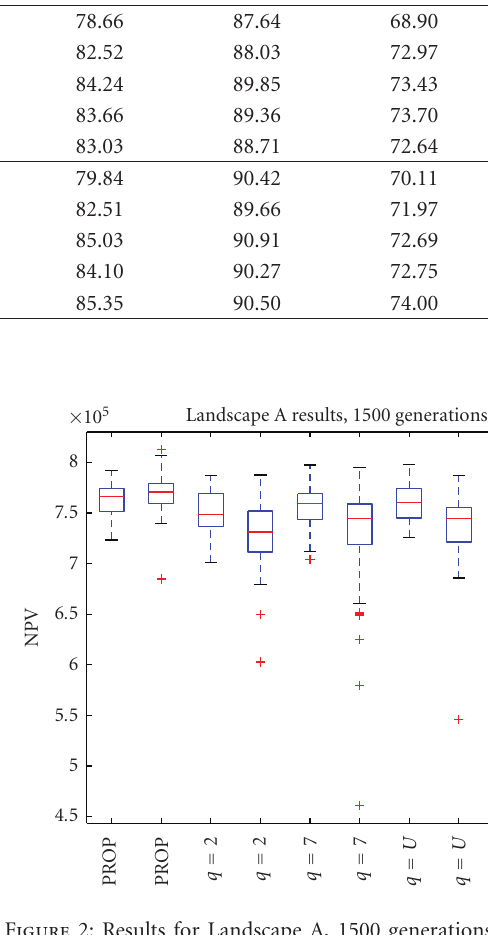
Figure 1: Results for Landscape A, 750 generations. This figure presents a box-plot of solution quality (NPV; y -axis) for each paired selection/penalty strategy tested. The x -axis displays the strategy; static and dynamic penalty strategies for the same selection strategy are displayed side by side (static on the left side). Reading from left to right, the first selection strategy presented is proportional selection and the rest are deterministic tournaments with various competitor pool sizes ( q ). The label “ q = U ” corresponds to the strategy wherein q was sampled from a uniform distribution over the range (2, 10), and the label “ q = 2–7” corresponds to the strategy where q increased from 2 to 7 during the search.